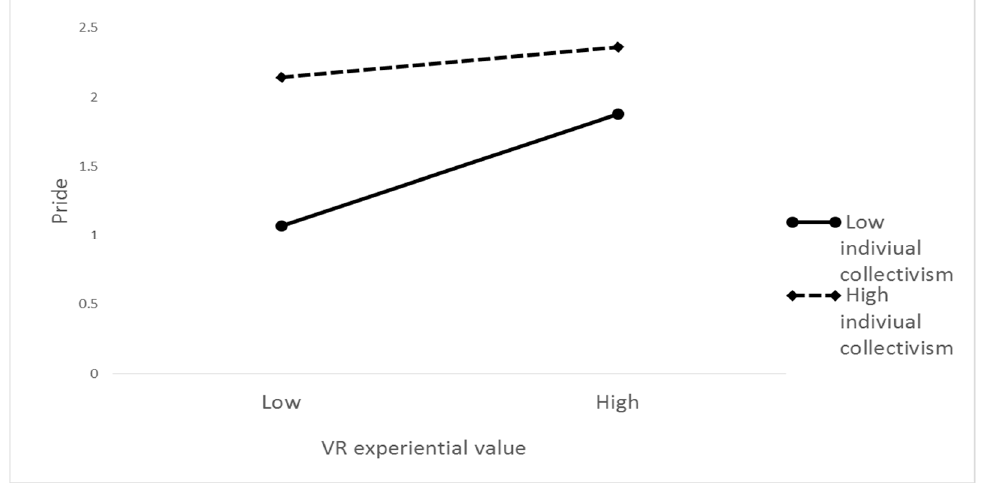
Figure 2. Moderating effect.